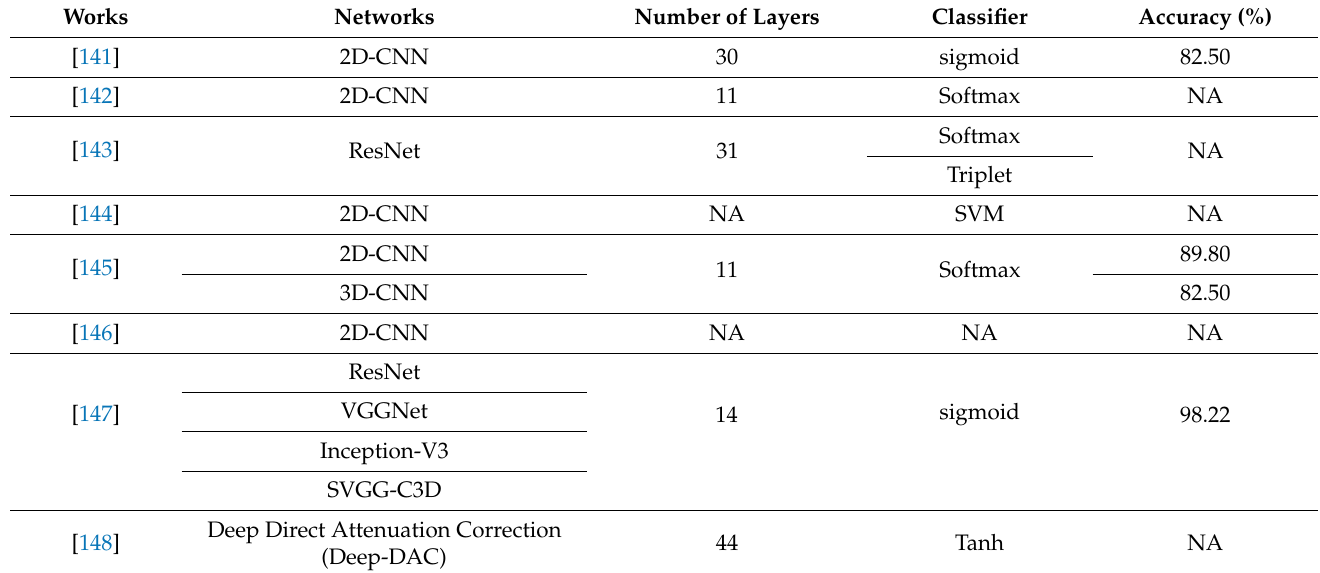
Table 8. Summary of related works done using MRI modalities and DL.